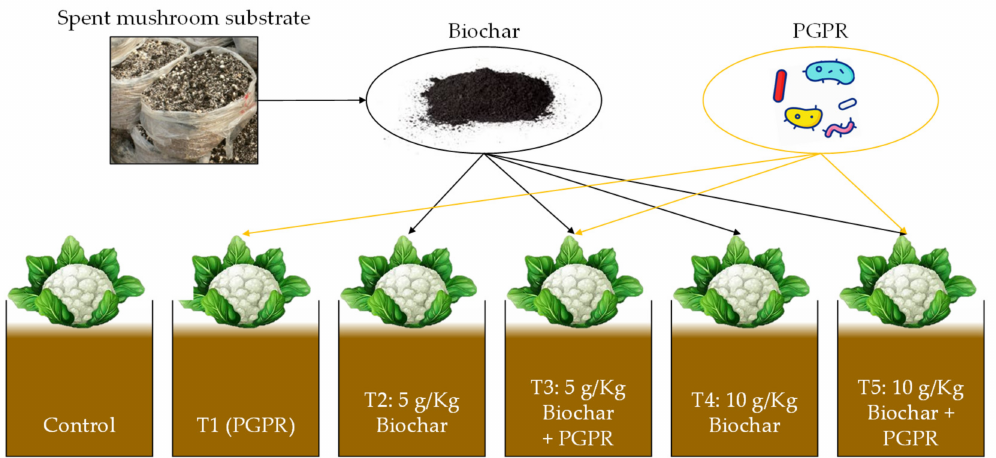
Figure 1. Experimental design for cauliflower cultivation using different treatments of the spent mushroom substrate (SMS) biochar and PGPR